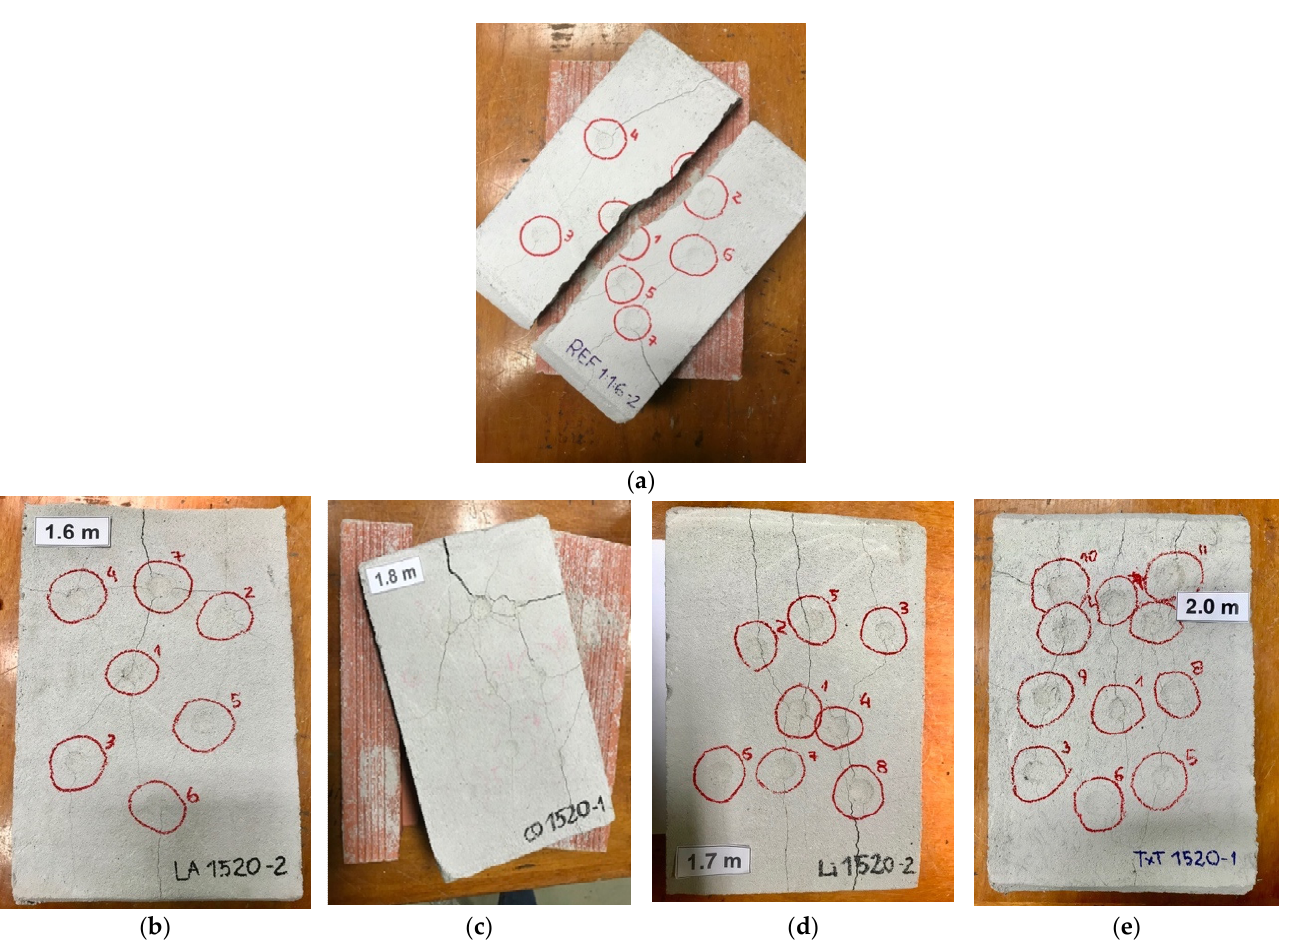
Figure 9. Crack pattern of cement-lime mortars, before ageing, at failure: ( a ) reference mortar, ( b ) wool fibre-reinforced mortar, ( c ) coir fibre-reinforced mortar, ( d ) flax fibre-reinforced mortar and ( e ) textile-acrylic fibre-reinforced mortar.